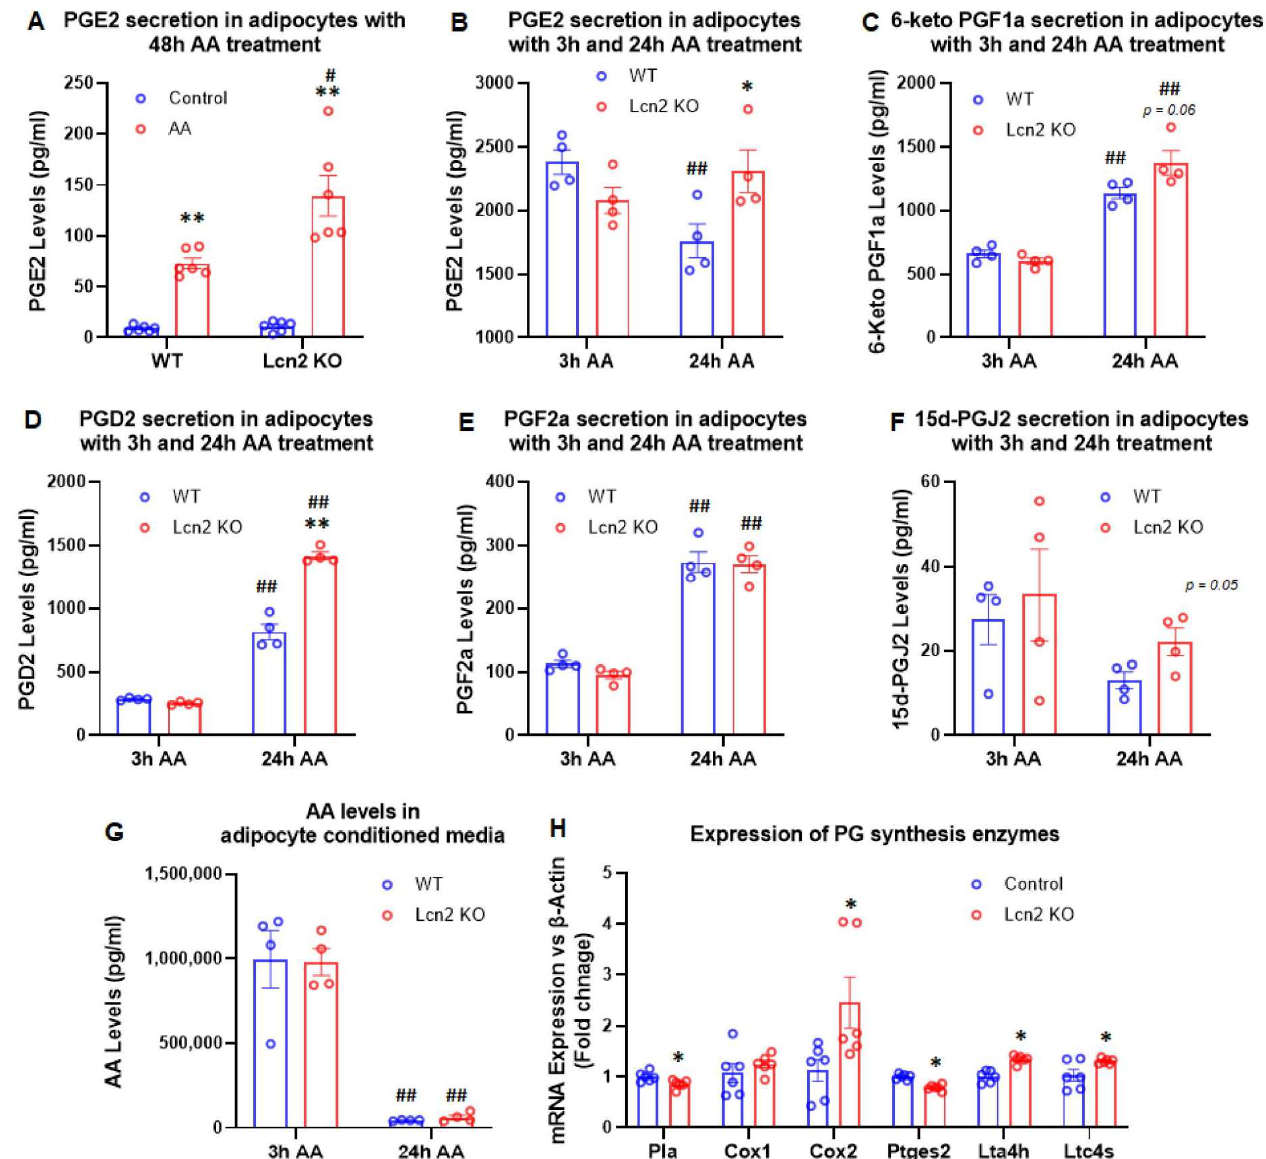
Figure 2. Prostaglandin production induced by AA in inguinal adipocytes. ( A ) PGE2 secretion in inguinal adipocytes treated with 150 nM AA for 48 h. ( B – F ) Secreted levels of PGE2, 6-keto PGF1a, PGD2, PGF2a, and 15d-PGJ2 in inguinal adipocytes treated with 150 nM AA for 3 h and 24 h. ( G ) AA levels in conditioned media of inguinal adipocytes. ( H ) Gene expression of PG synthesis enzymes in inguinal adipocytes. Results are presented as mean ± SEM ( n = 4 for ( A – G ); n = 6 for ( H )). * p < 0.05, ** p < 0.01 versus WT adipocytes. # p < 0.05, ## p < 0.01 versus 3 h AA treatment.